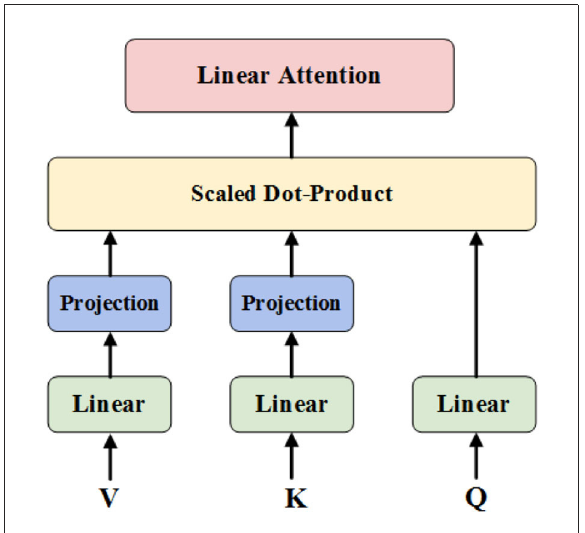
FIGURE2 Linear-Attention